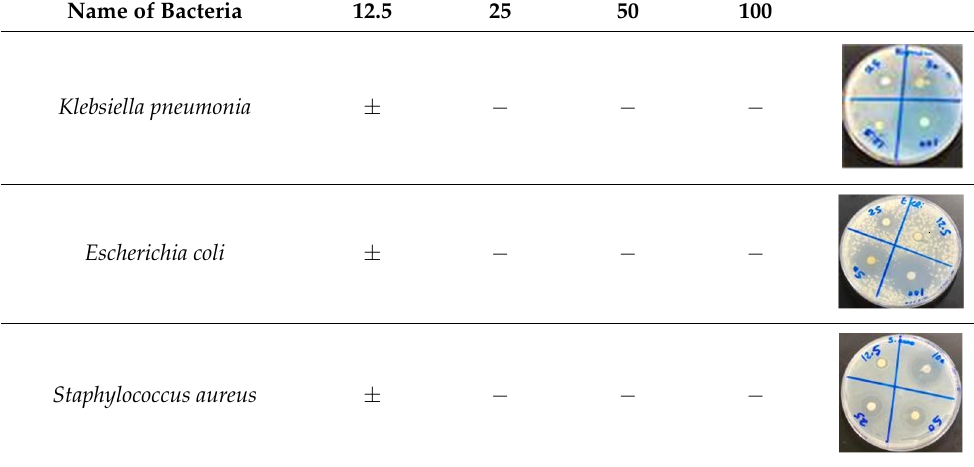
Table 6. MIC of different dilutions of (C 9 H 14 N) 2 [CuCl 4 ].Growth in nutrient agar containing different